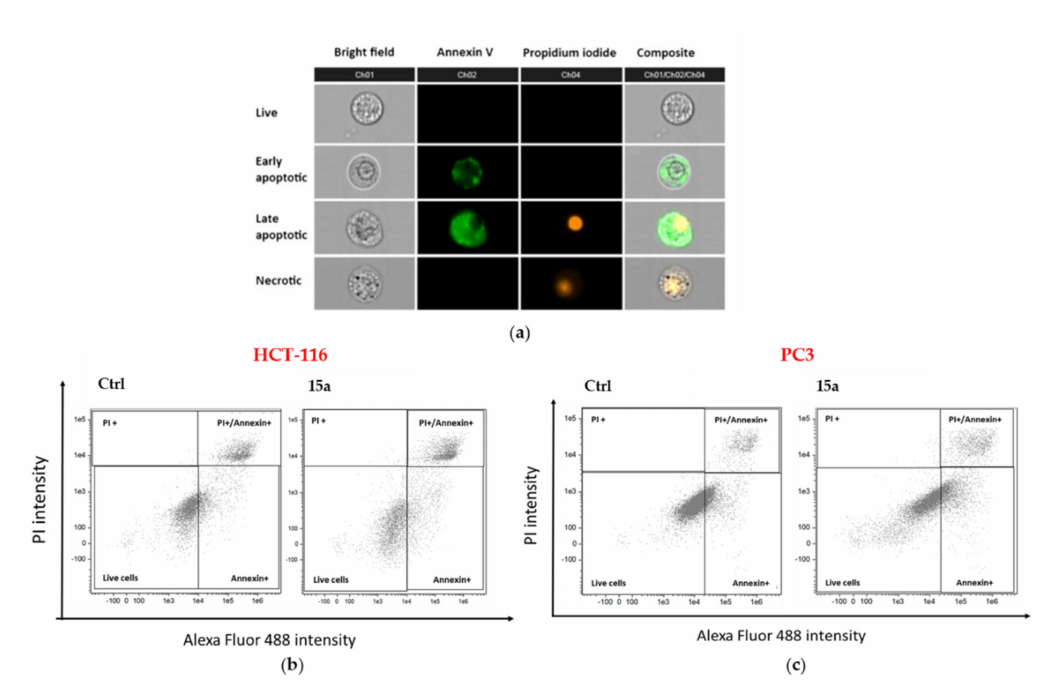
Figure 3. Flow cytometry: ( a ) Typical images of cells analyzed by flow cytometry (Amnis FlowsSigh). Each cell (event) is visible in a bright field and stained by annexin-V positive, propidium iodide positive, and double positive cells; Flow cytometric dot plot of specific cell populations in HCT-116 ( b ) and PC3 ( c ) cell lines in the presence of 15a: live (double annexin / PI negative), necrosis (annexin negative and PI positive), early apoptosis (annexin positive), and late apoptosis (double annexin / PI